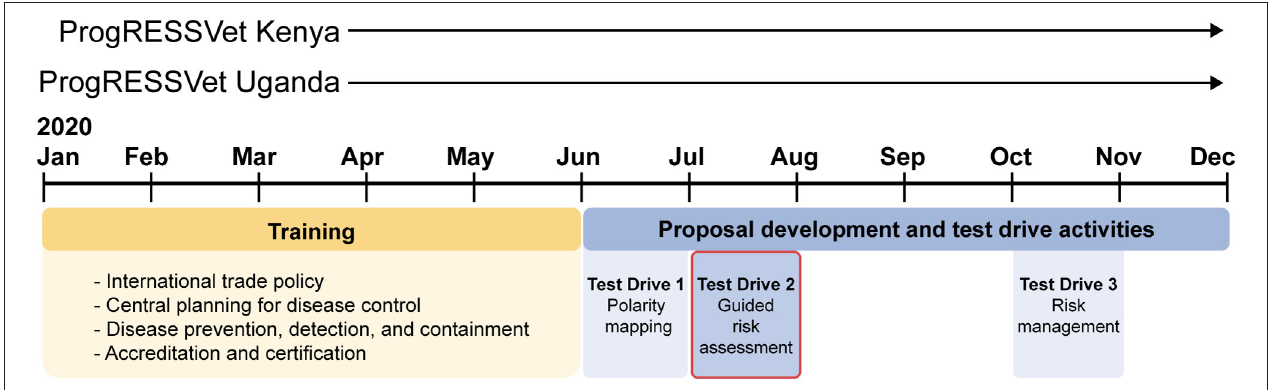
FIGURE 1 | Research and training activities were carried out within 2 concurrent cohorts of ProgRESSVet: one in Kenya and one in Uganda. Participants completed 5 months of online coursework followed by 6 months developing proposals to support the trade of animals and animal products. The guided risk assessment was one of three “Test Drive” activities integrated into the curriculum which included participants in the process of data collection and synthesis about questions relevant to their own communities. The Test Drives, including the guided risk assessment, were part of the training program; participants could opt in for their contributions to be used for research purposes. All training and research activities were carried out separately in each